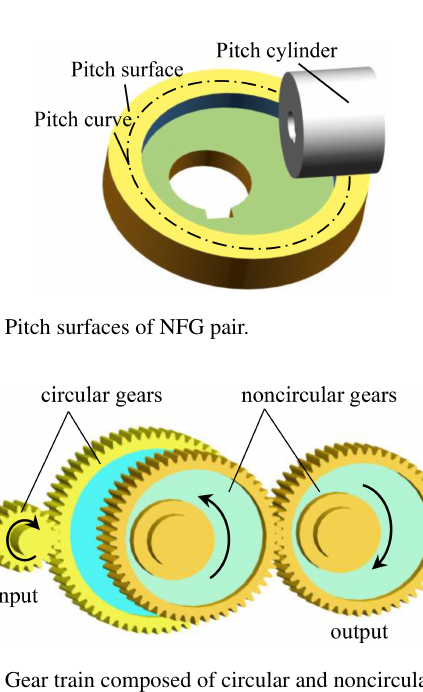
Figure 3. Gear train composed of circular and noncircular gears.